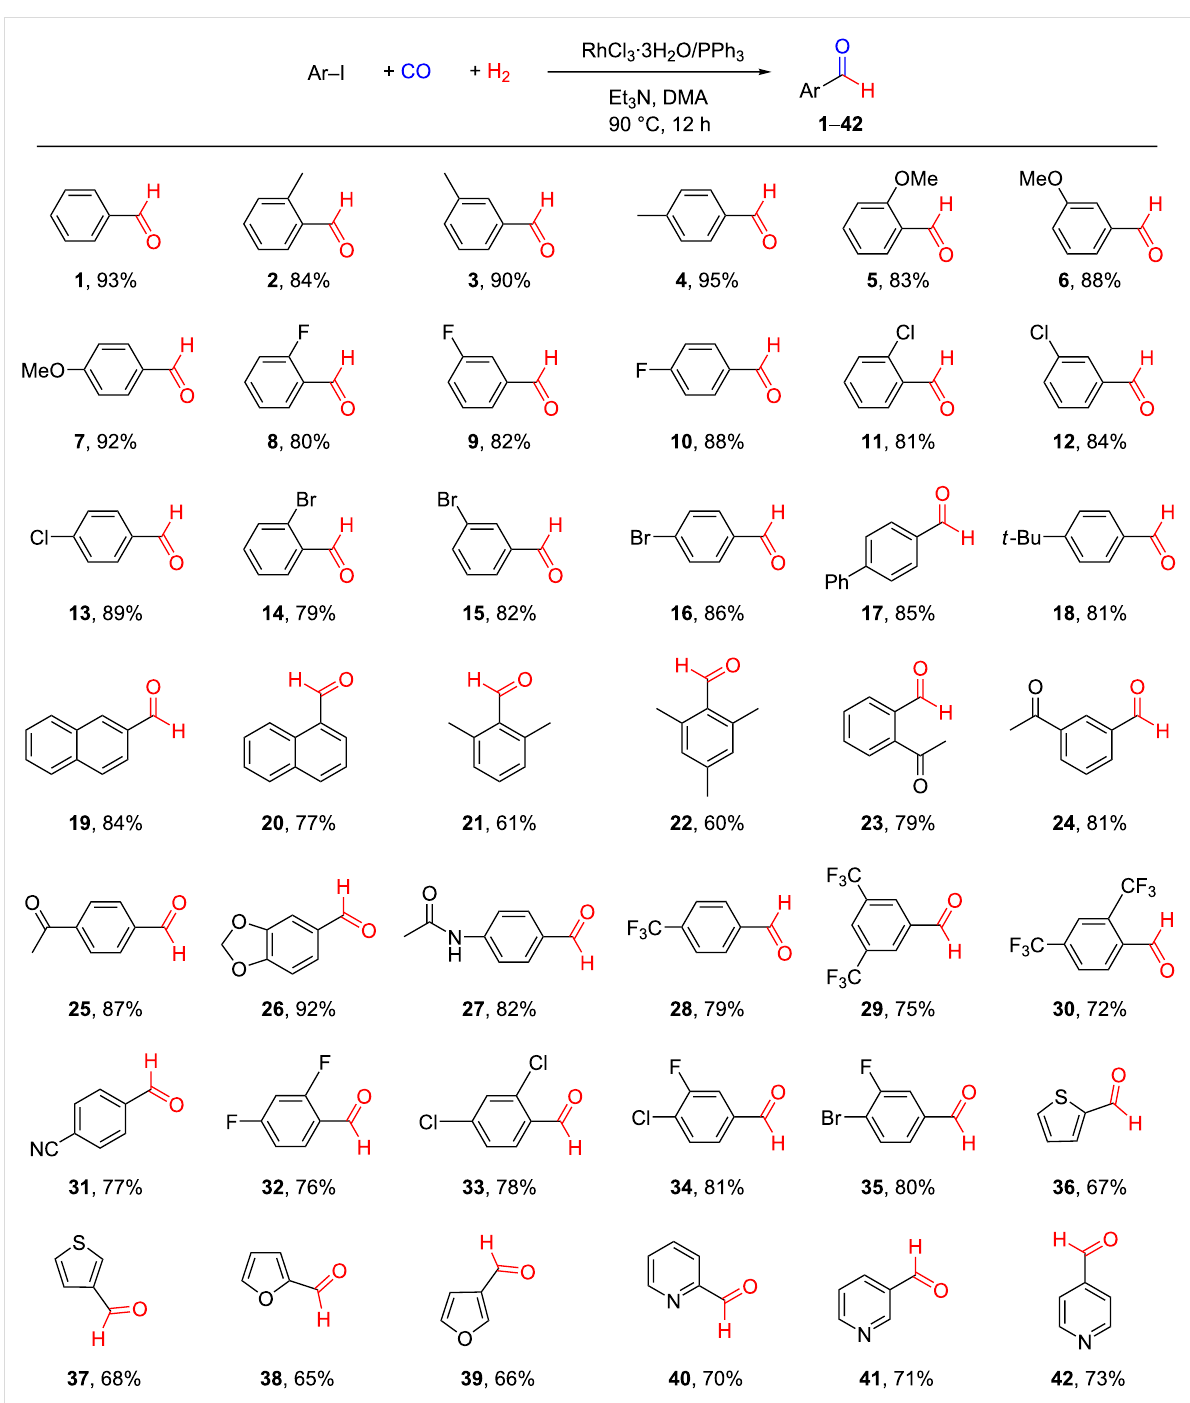
Scheme 3: Substrate scope for the Rh-catalyzed reductive carbonylation of aryl iodides using CO and H 2 . Reaction conditions: PhI (1 mmol), RhCl